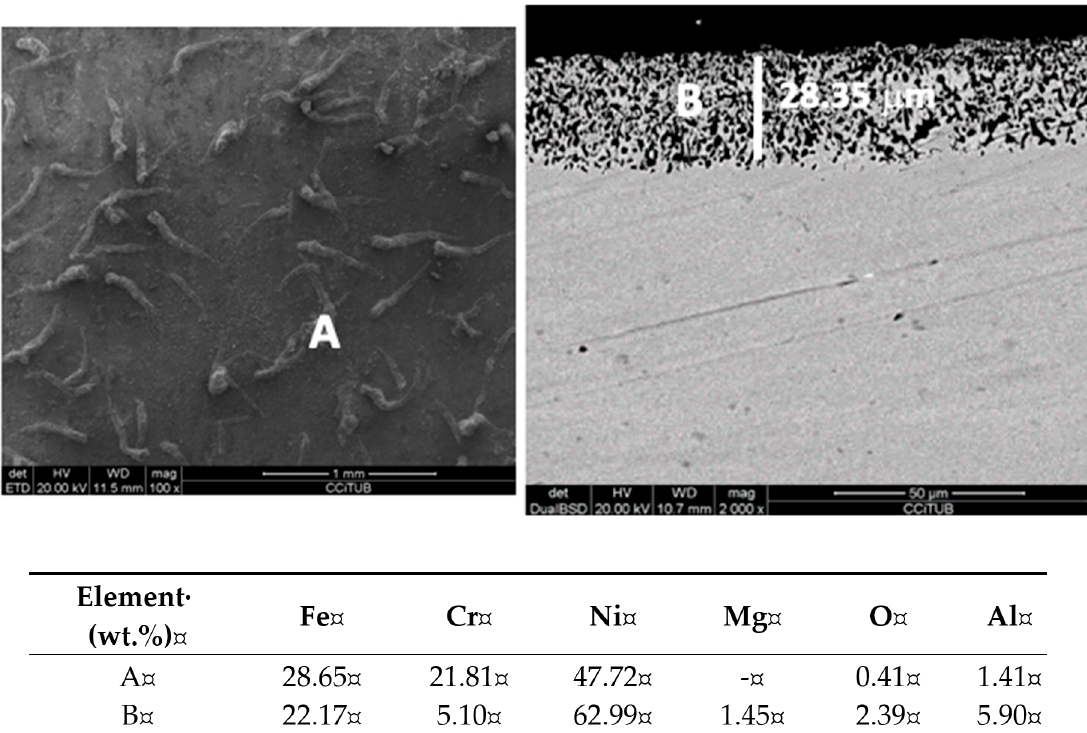
Figure 5. Top view ( left ) and cross-section; ( right ) images for HR224 alloy immersed in chloride molten salt for 50 h at 720 ◦ C including EDX analysis